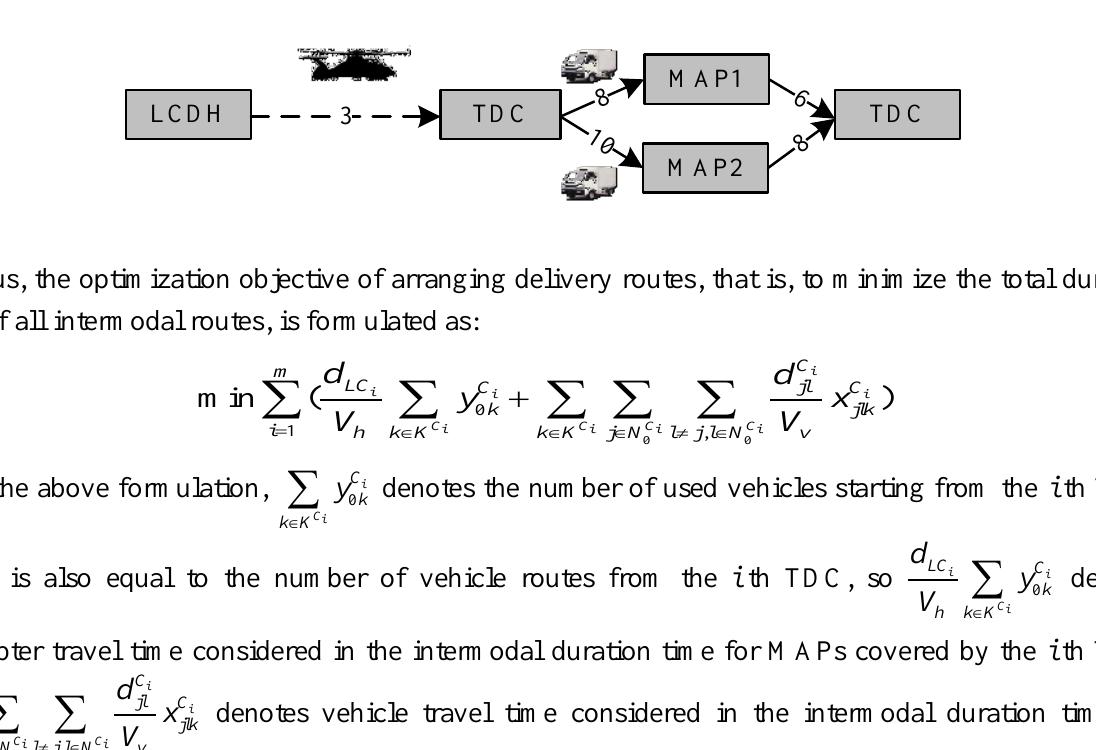
Figure 2. The duration time of intermodal